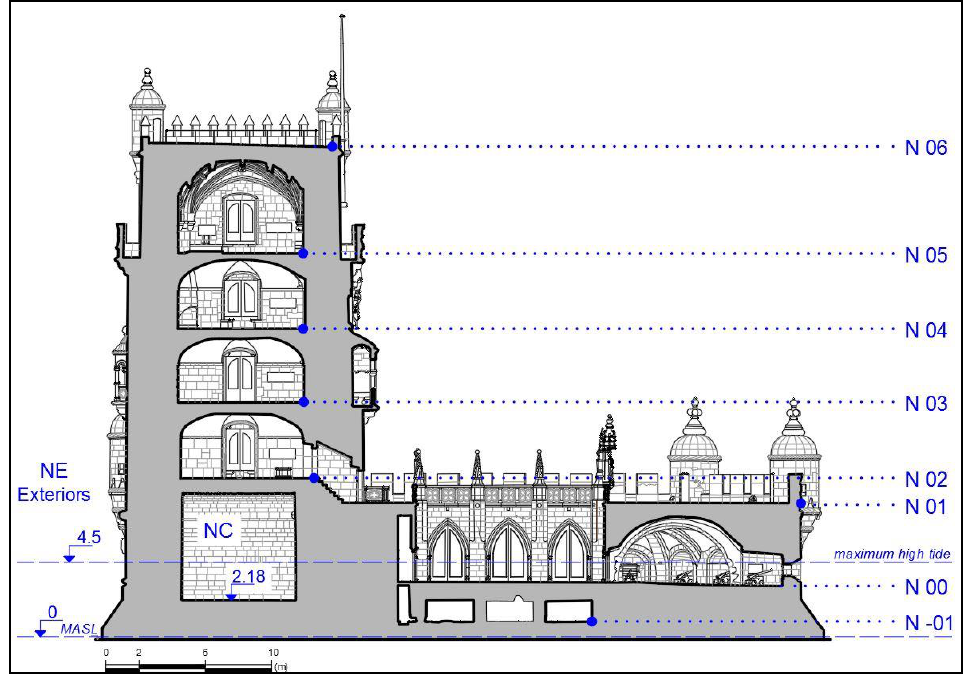
Figure 6. Levels surveyed in the Tower of Belém.